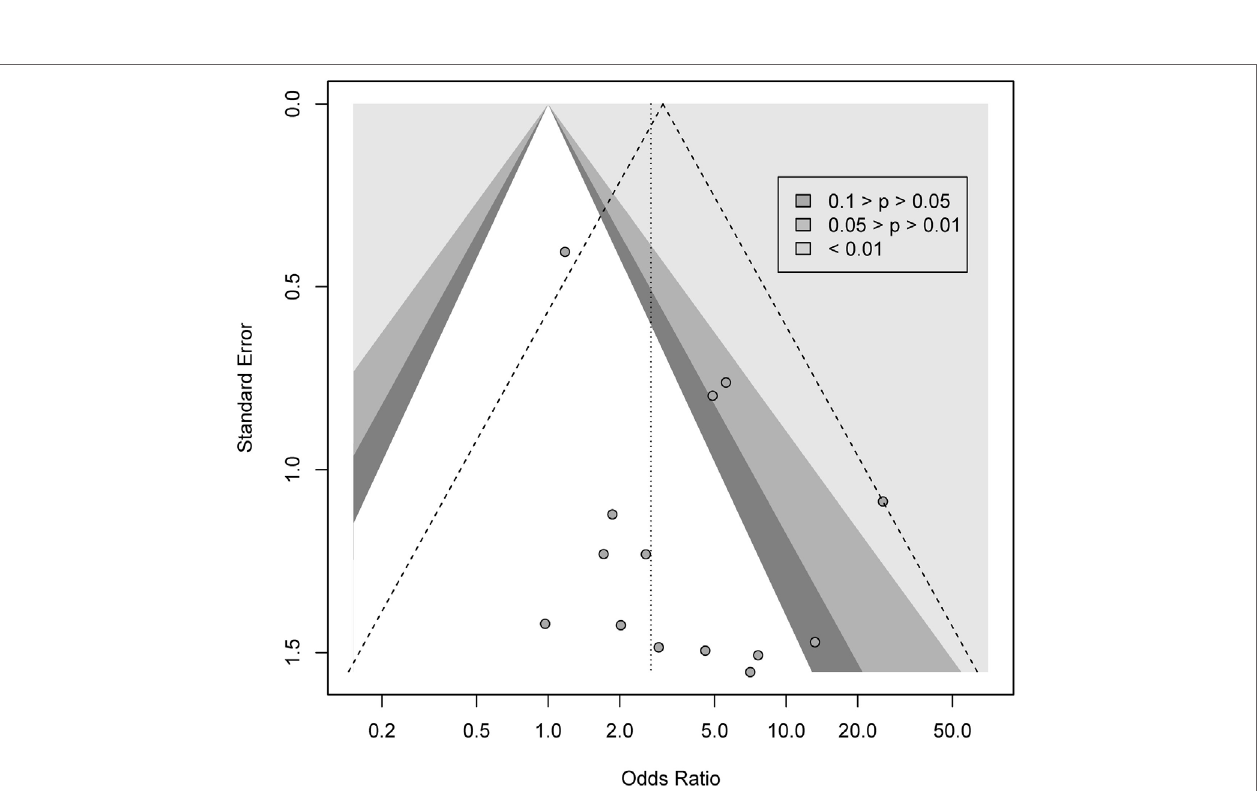
FigURe 5 | Contour-enhanced funnel plot for gambling.